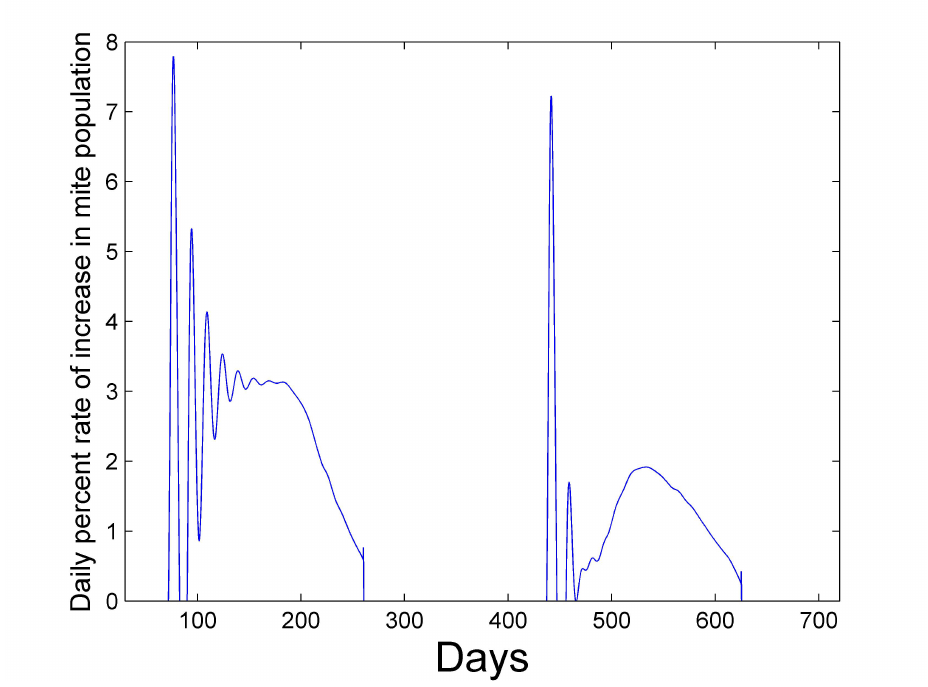
Figure 4. Daily percent rate of increase in mite population as defined by (16). After a period of oscillation, the rate relaxes. The average rate in the first year is 2.6% and the average rate in the second year is